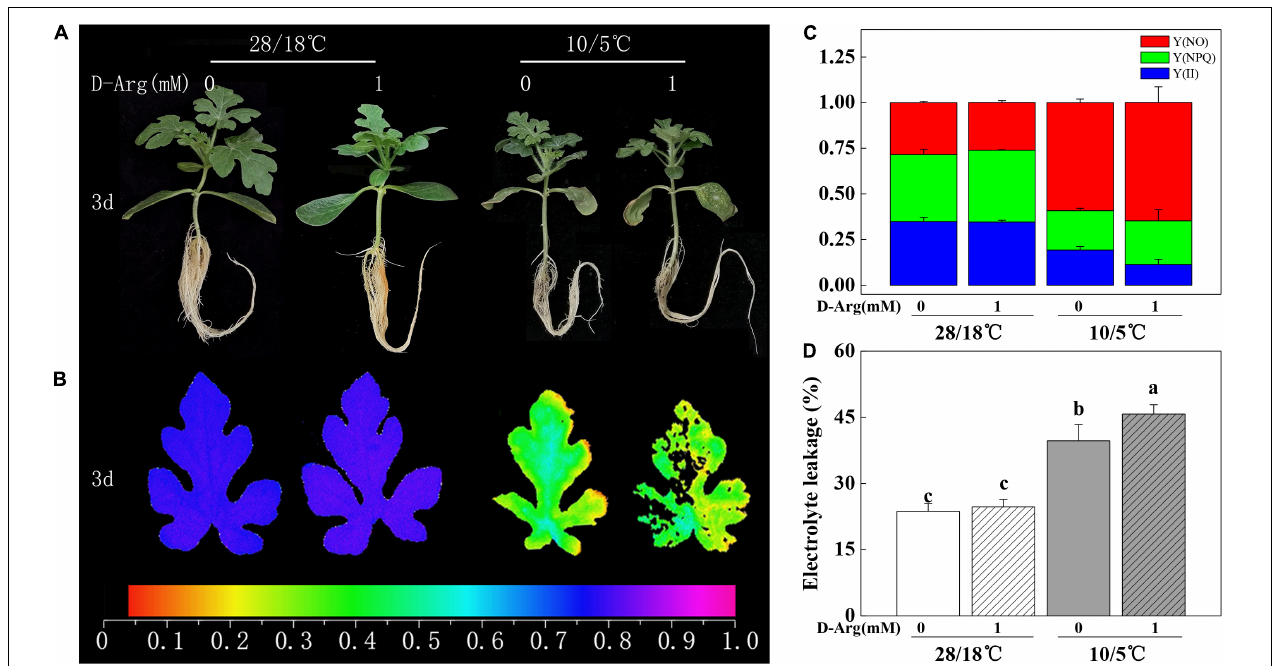
FIGURE 3 | Effects of putrescine synthesis on pumpkin rootstock-induced chilling tolerance in watermelon seedlings. (A) Representative images of chilling phenotypes. (B) Images of the maximum quantum yield of PS II ( Fv/Fm ). (C) Fraction of Y(II), Y(NPQ) and Y(NO). (D) Electrolyte leakage. The color gradient of the images in Fv/Fm provided at the bottom of this figure B ranges from 0 (black) to 1.0 (purple). Values are means ± SE ( n ≥ 4) and different letters on the histograms indicate significant differences ( P < 0.05, one-way ANOVA). Cl/Cm seedlings were spray pretreated with 1 mM D-arginine or water (Wu et al., 2016), 12 h